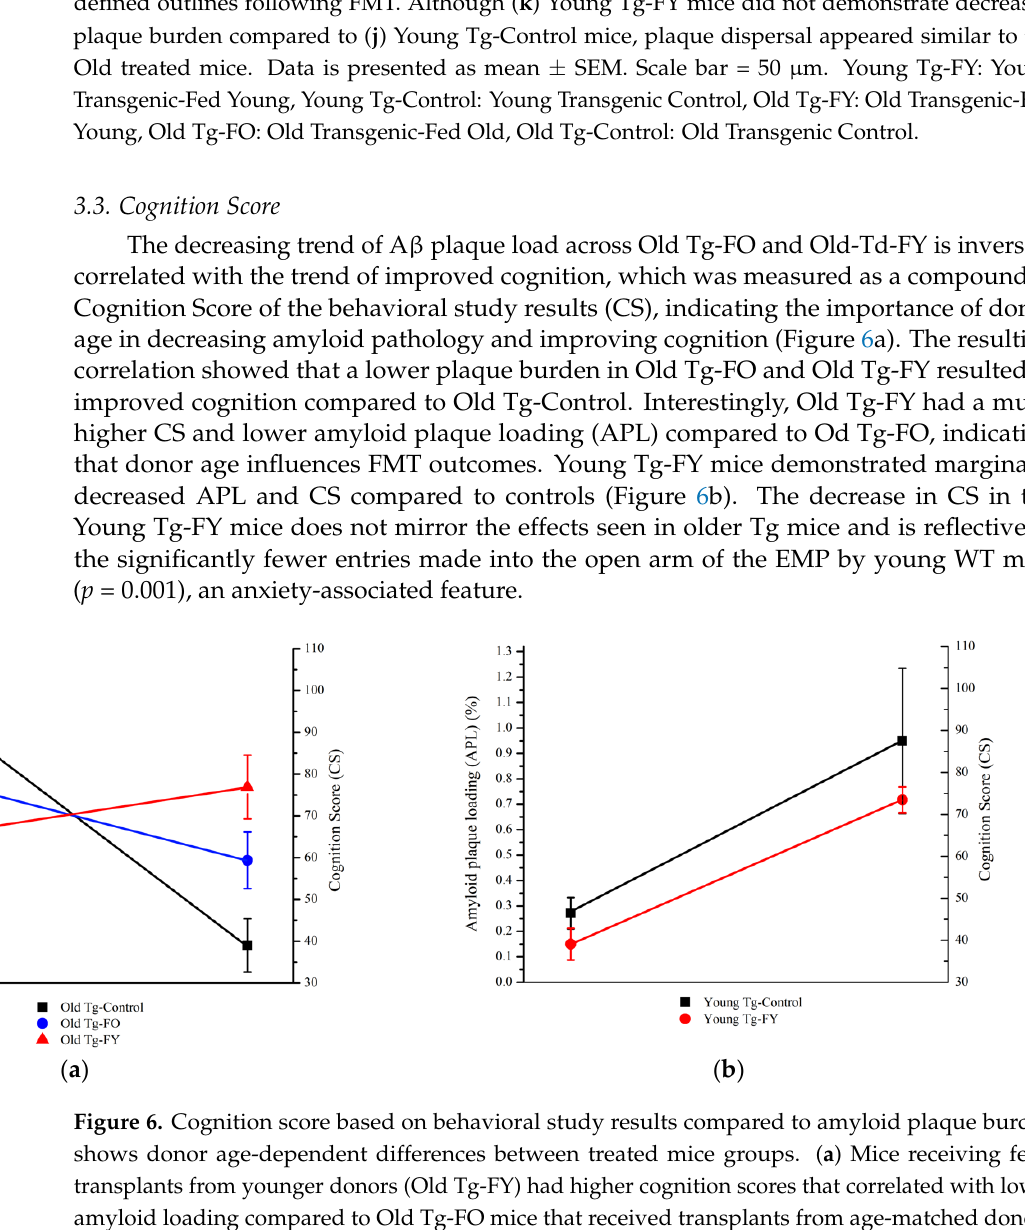
Figure 5. FMT resulted in decreased amyloid plaque burden in treated mice as seen in Thioflavin